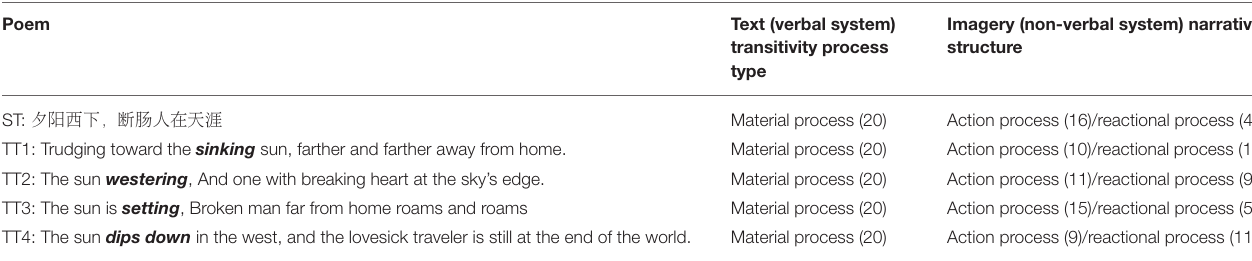
TABLE 1 | Imagery comparison in verbal and non-verbal systems. Poem